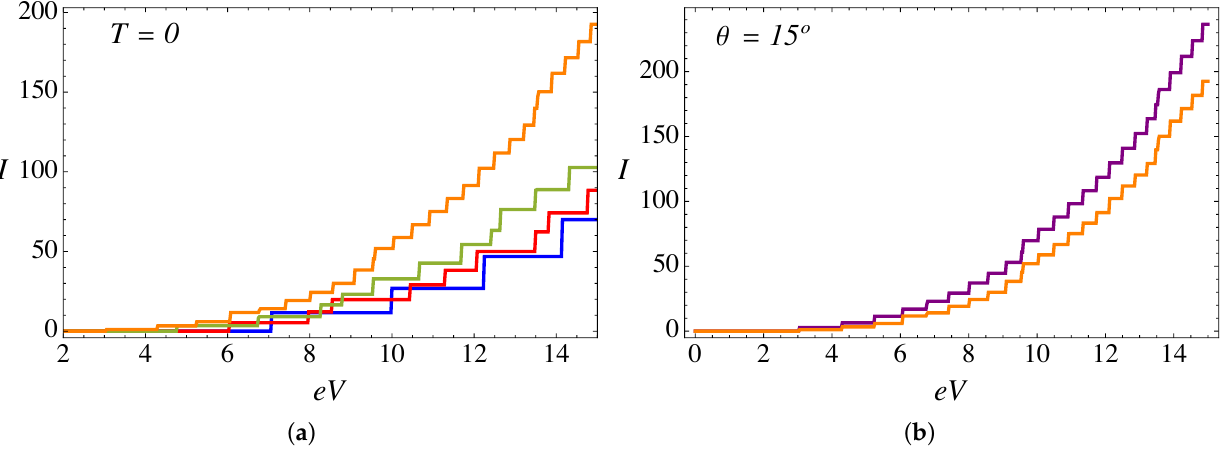
Figure 6. (Color online) ( a ) Electric current (in units of ev F / a ) as function of applied bias eV (in units of ¯ hv F / a ), computed from the analytical expression in Equation (9) at zero temperature, for an external magnetic field B 0 a 2 = 25 ˜ φ 0 and α = 3 π /4. The blue line corresponds to a twist angle θ = 0 ◦ , red is for θ = 5 ◦ , green is for θ = 10 ◦ , and the orange line corresponds to θ = 15 ◦ . ( b ) Comparison of electric currents at zero temperature, for B 0 a 2 = 25 ˜ φ 0 and θ = 15 ◦ : the purple line is for α = 0, and the orange line corresponds to α = 3 π